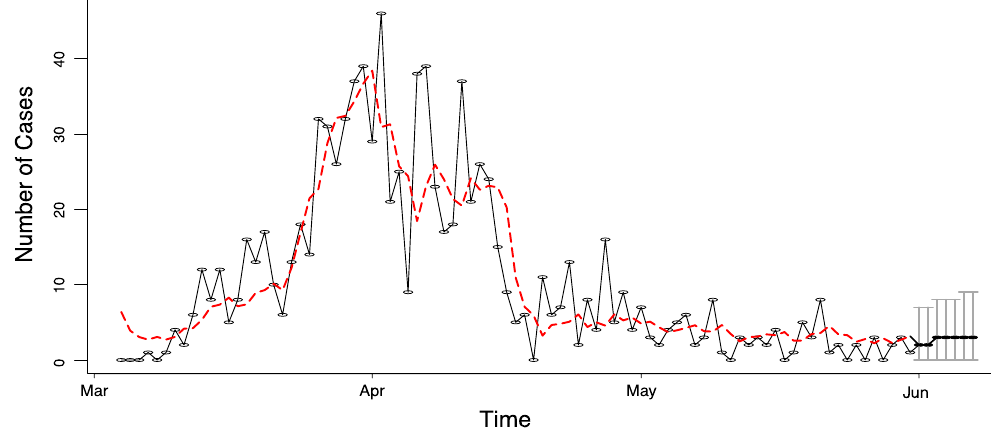
Figure 6. Daily number of COVID-19 cases in Cyprus from 01/03/2020 to 31/05/2020 (black line) and the fitted model with interventions (red line). The grey bars at the end of the plot show 95% simultaneous prediction